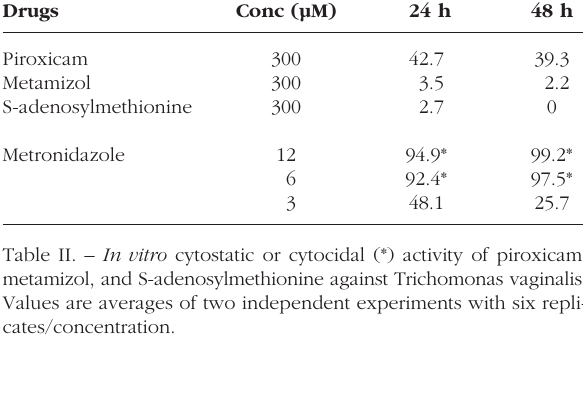
NOGAL-RUIZ J.J., GÓMEZ-BARRIO A., ESCARIO J.A. ET AL.